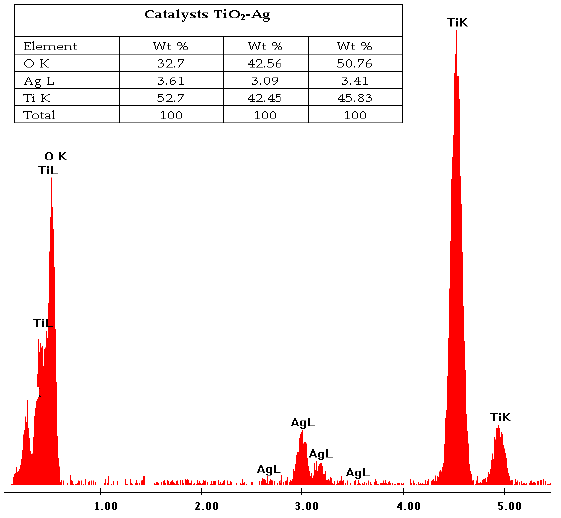
Figure 3. Elemental analysis of catalyst showing fractions of titanium, oxygen and silver metal. The results of three measurements made on the catalyst are shown. The average weight of the metallic silver deposited is 3.3%; the theoretical percentage was 5%.